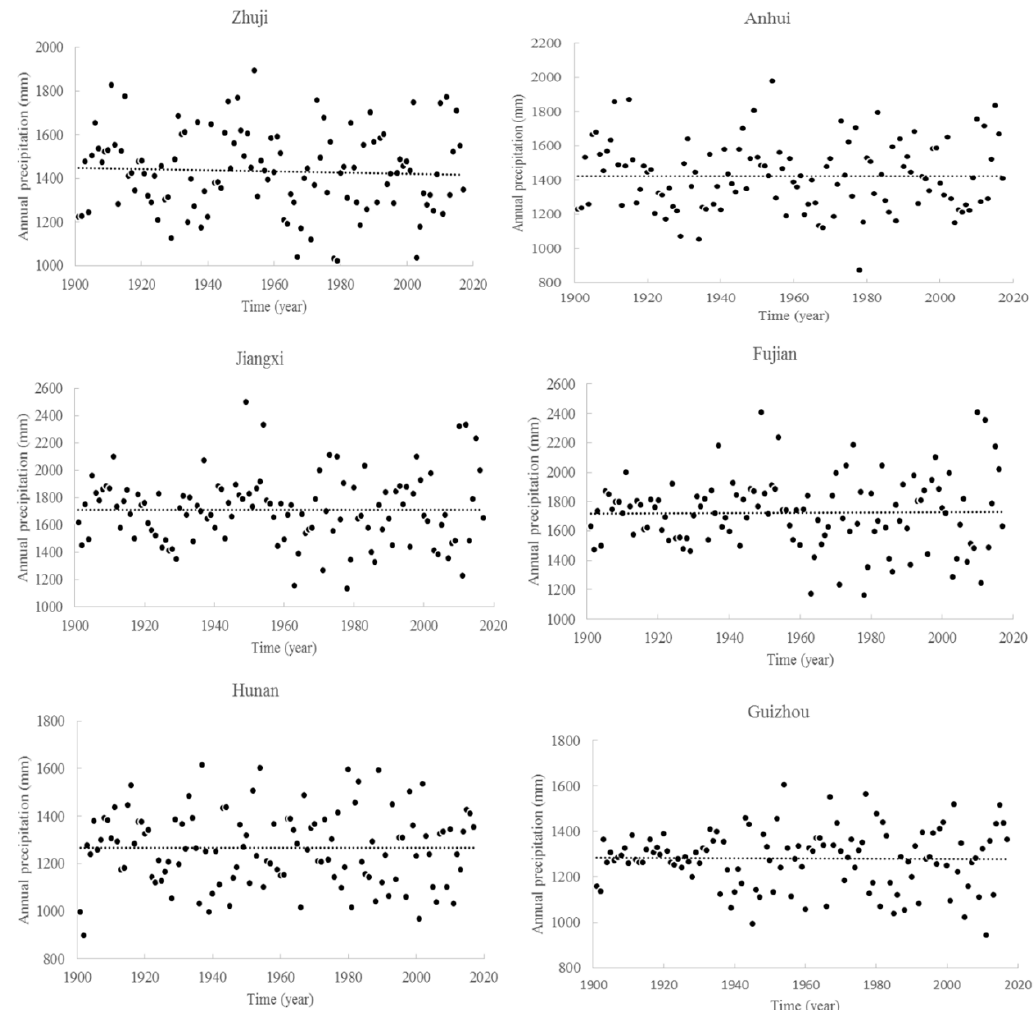
Figure 3. The change of annual precipitation in the six regions with Chinese Torreya plantations.